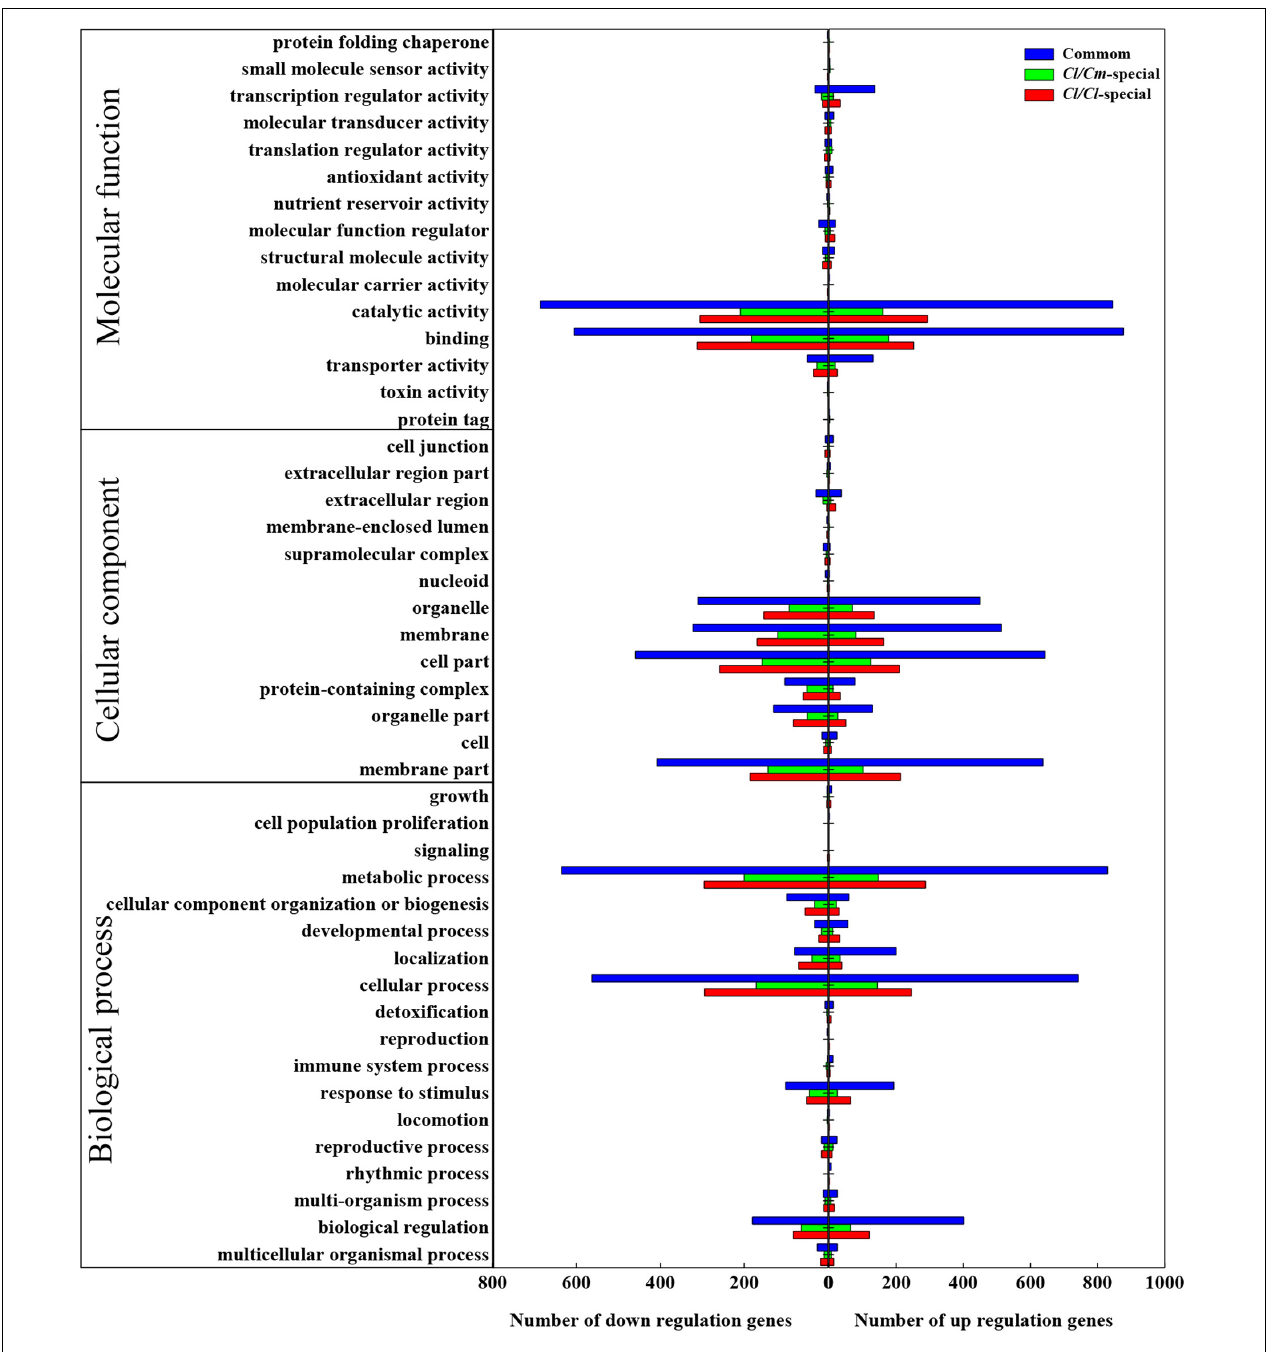
FIGURE 6 | Gene ontology functional analysis of DEGs in Cl/Cl -LT and Cl/Cm -LT libraries. The x-axis indicates the percentage of up- or down- regulated genes in Cl/Cl or Cl/Cm libraries under chilling stress in each GO term. The y-axis shows the names of functional categories.